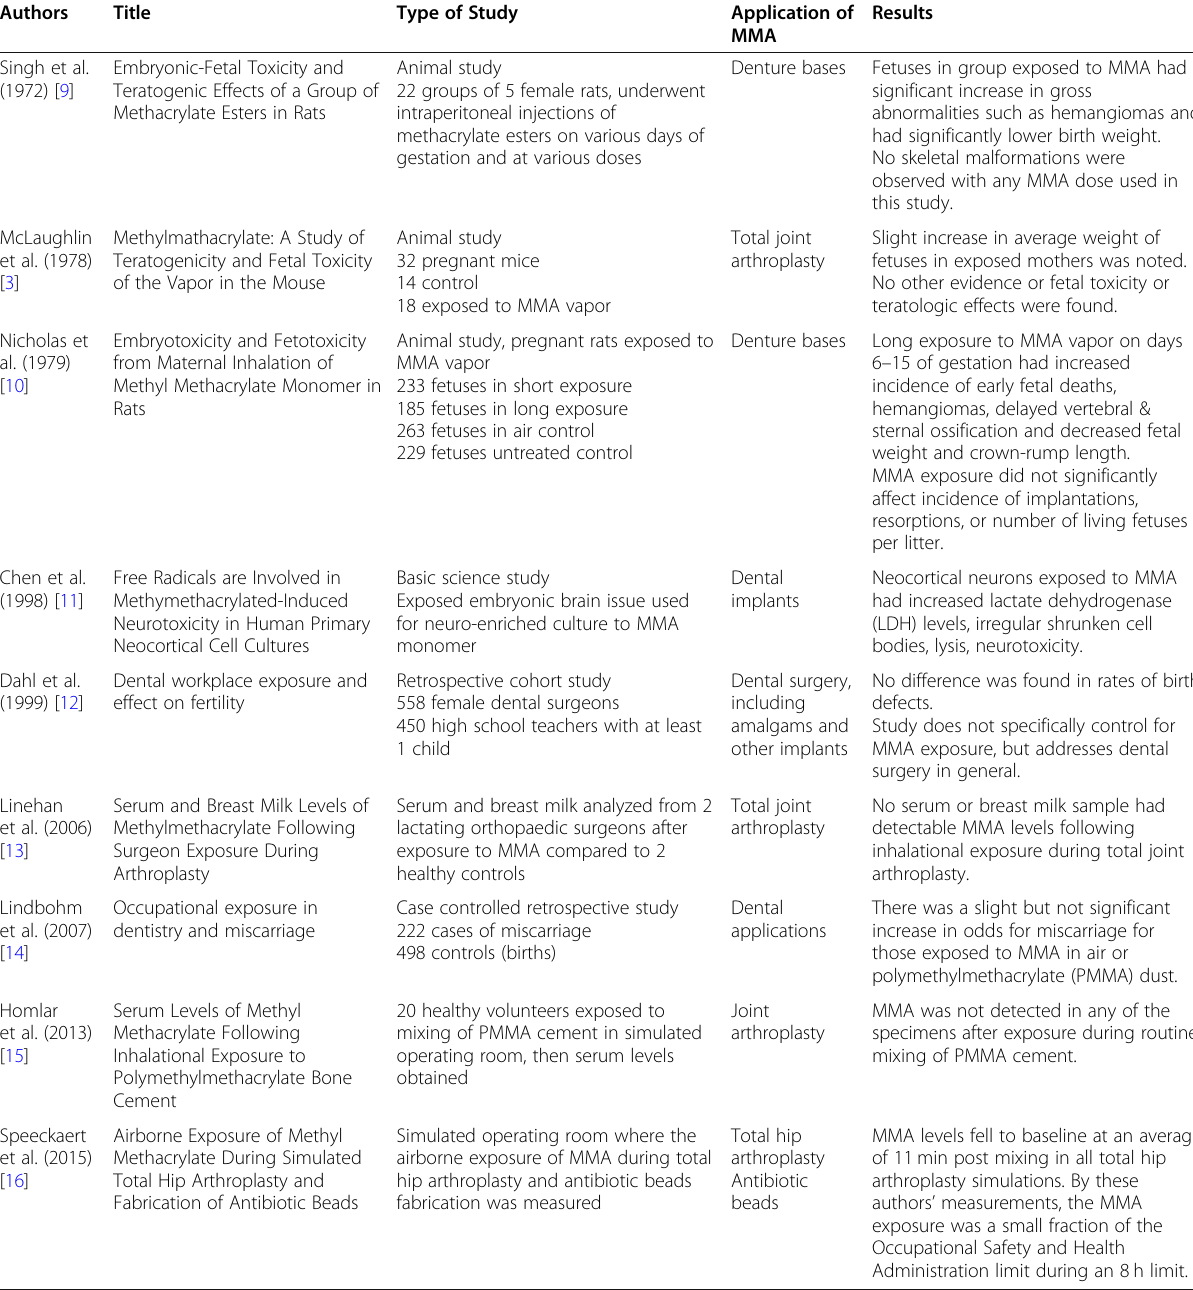
Table 1 Studies included in final